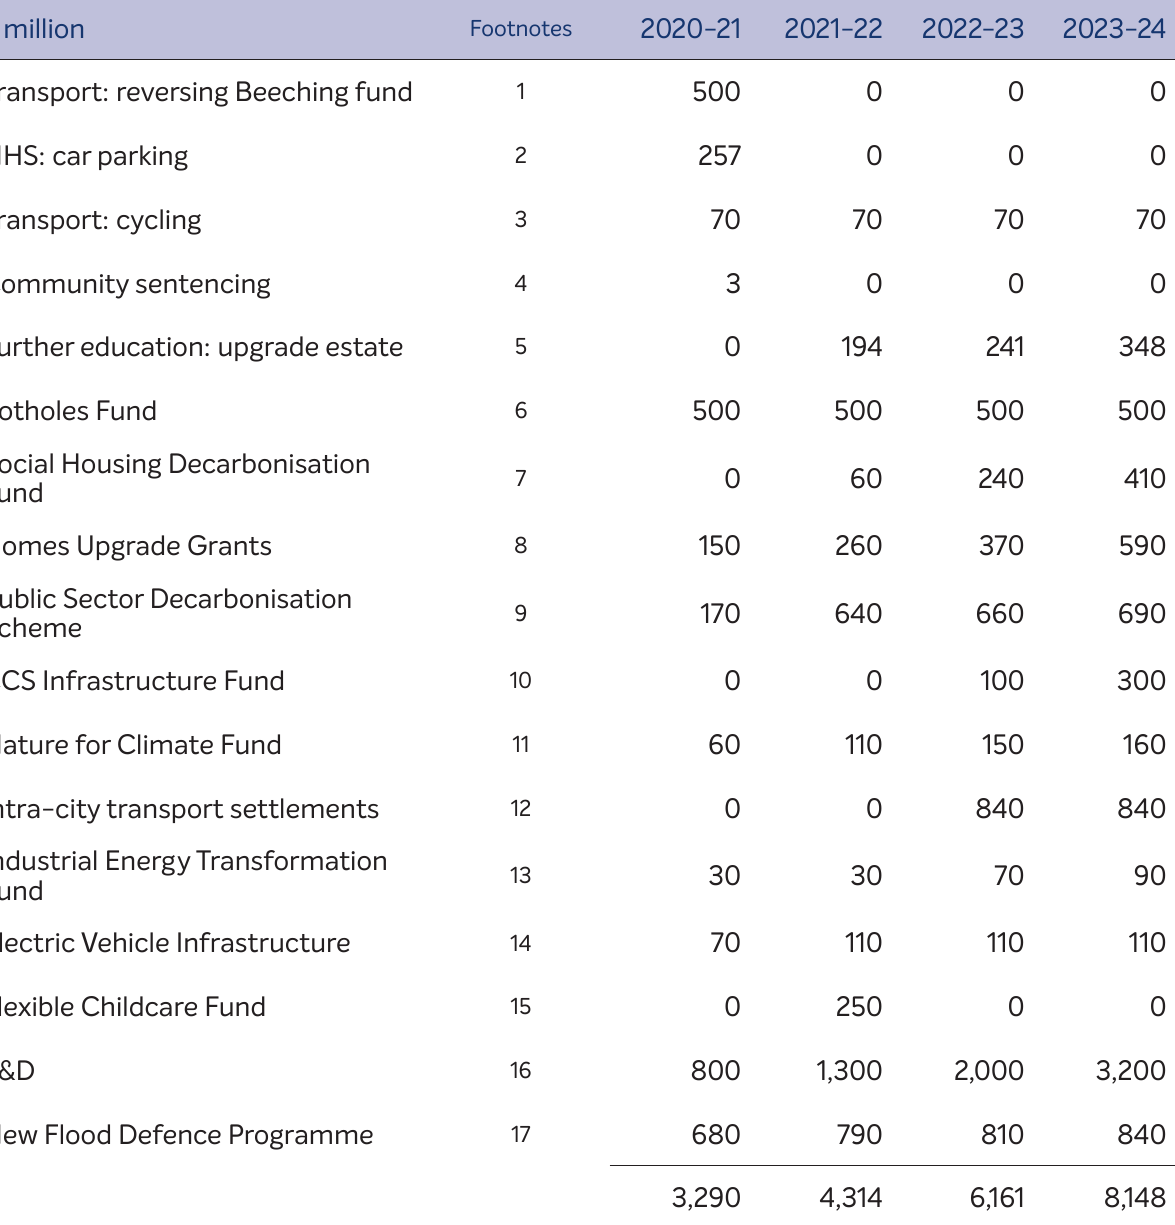
Table 6: Capital